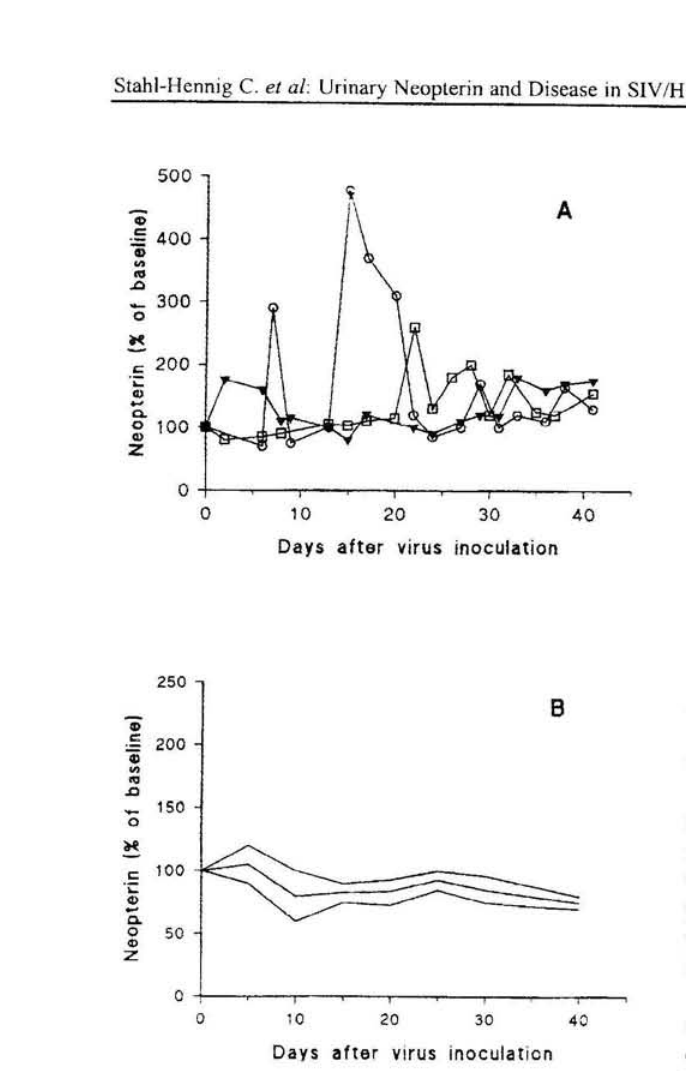
Figure 2: Course of urinary neopterin concentrations (mean ± S.E.M.) in rhesus and cynomolgus monkeys after inoculation with SIV or HIV-2. Neopterin con- centrations obtained after inoculation were related to preinoculation values and expressed as percent of mean baseline values. The diagram shows the mean neopterin concentrations of (A) rhesus monkeys remaining seronegative after inoculation with SIV (n=3, animal No. 5018 - open squares, 5022 - open cir- cles, 5023 - filled triangles - from Tablel) and of (B) cynomolgus monkeys remaining seronegative after inoculation with HIV-2 (n=5; animal No. 5348, 5353, 5355, 5357, 5358 from Table 1). Note the scale differ- ence on the